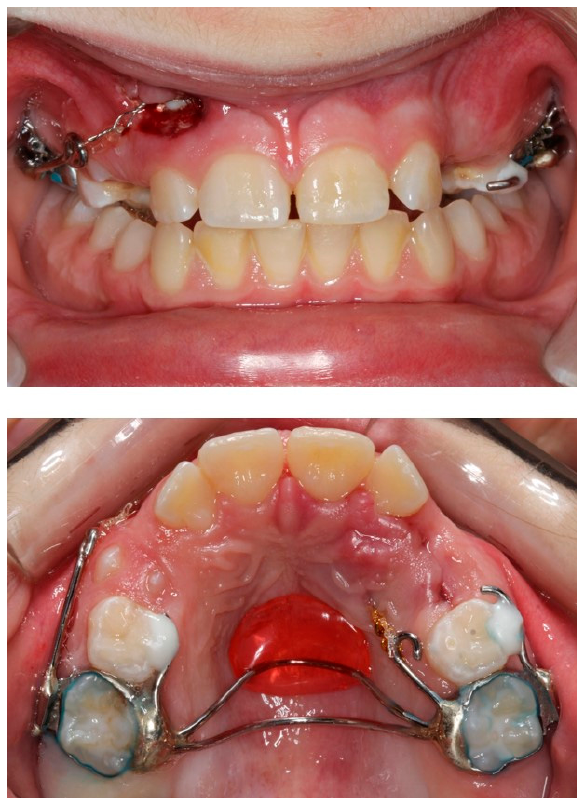
Figure 6. The custom-made trans-palatal arch used for the traction of the impacted canines.